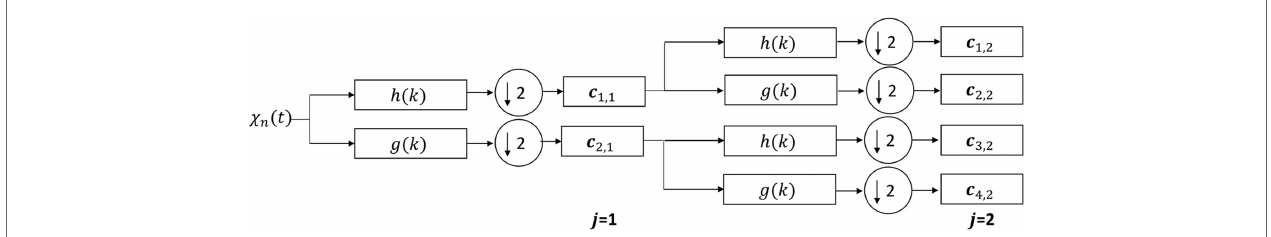
FIGURE 4 | Wavelet packet transform schematic diagram up to decomposition level 2. At each level, the frequency spectrum is split into 2 j sub-bands.